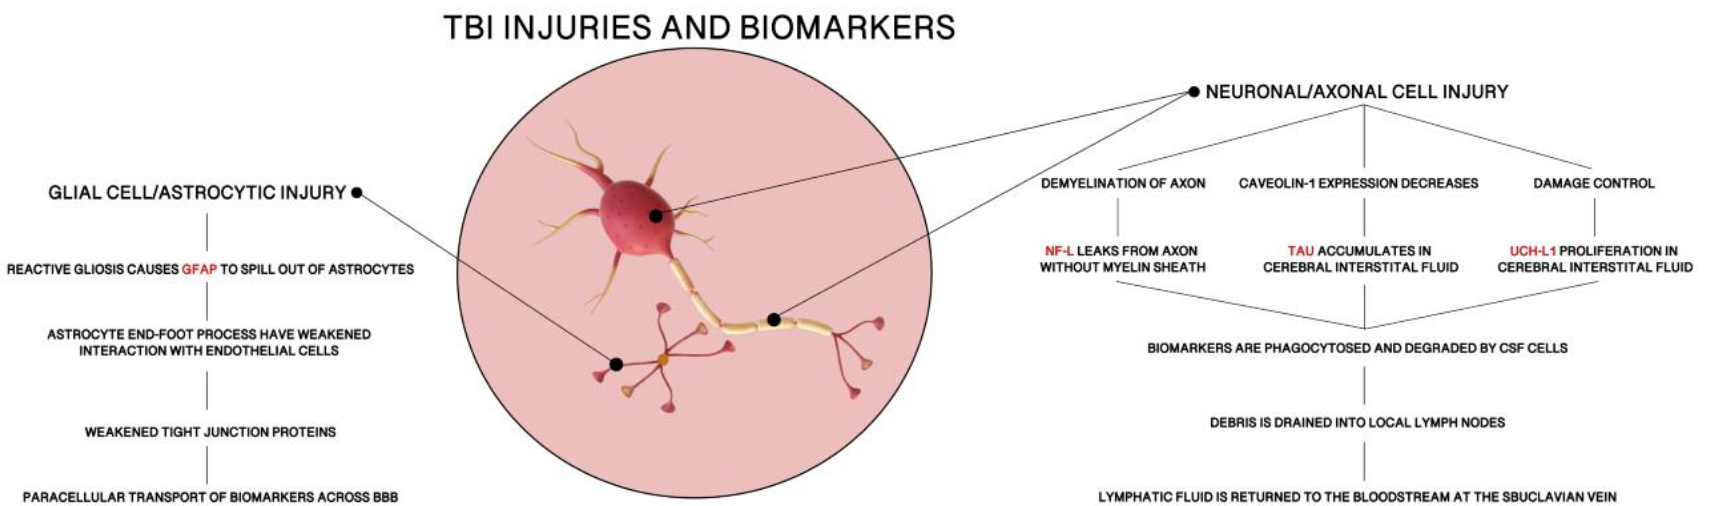
Figure 47. Pathway for biomarkers (GFAP, UCHL1, tau and NF-L) studied in this research all involving injury at cellular and neuronal/axonal levelS100B is presented below. Since this work is under development for a future article in Bioengineering, we will not discuss the format in which the data presentation will be carried out. Figure 40 shows a typical kinetic plot for S100B, data shows rapid decline in the concentration after 2 weeks while the half-life is before one-week after injury. Normalized data presented in terms of concentration with respect to time in Figure 48A. Attempt was made to reorganize the data in a new format in Figure 48B showing the concentration gradient with respect to time after injury. This behavior will be modeled by Michaelis-Menten equation [121].